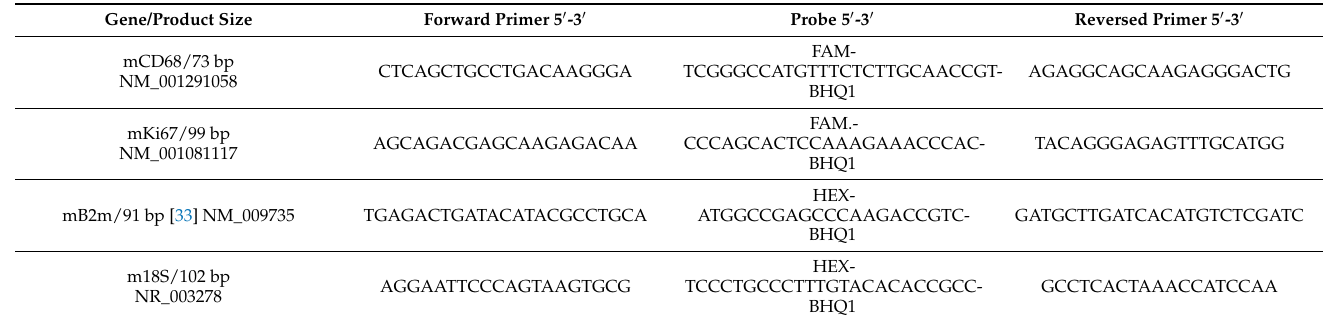
Table 1. RT-PCR Primers and